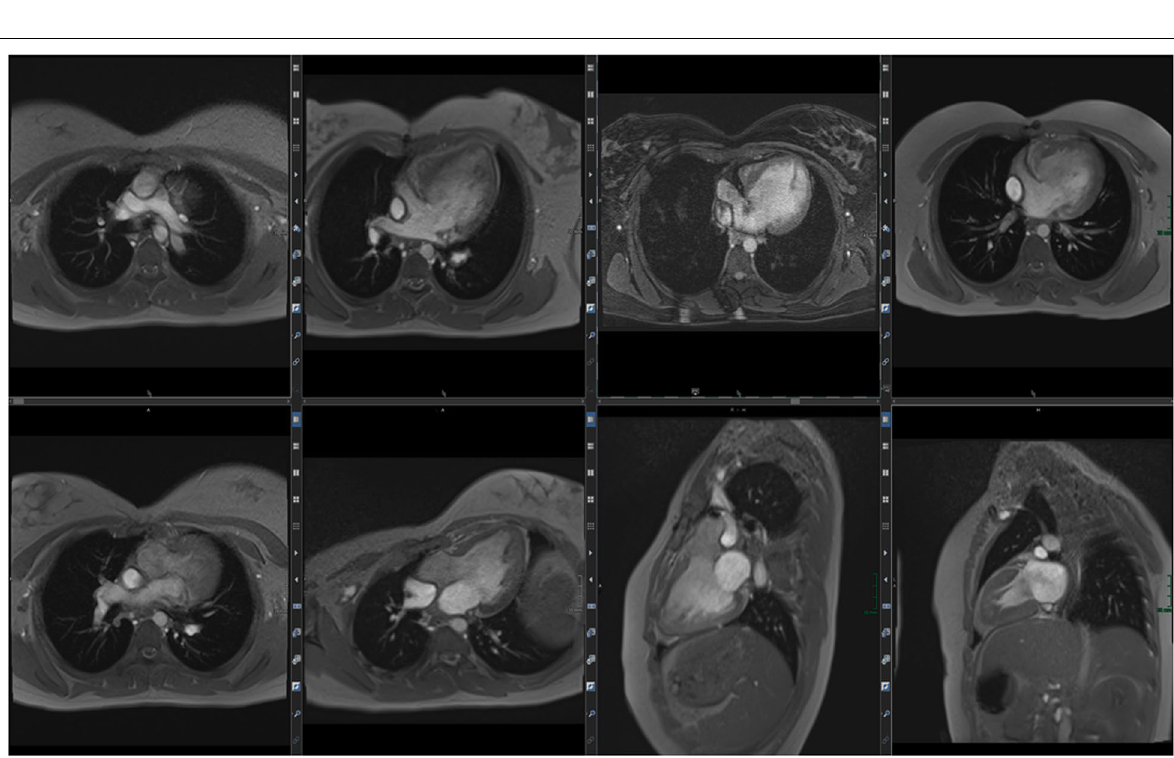
Fig. 11 (Functional and anatomic imaging by CINE): 4CV, 3CV, 2CV, and axial CINE show the enlarged and hypertrophied LV as well as the